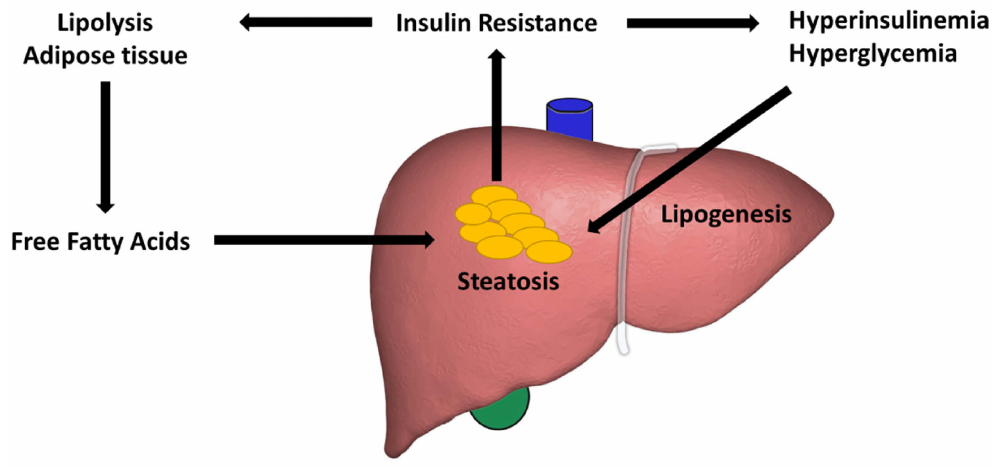
Figure 2. Role of insulin resistance in hepatic